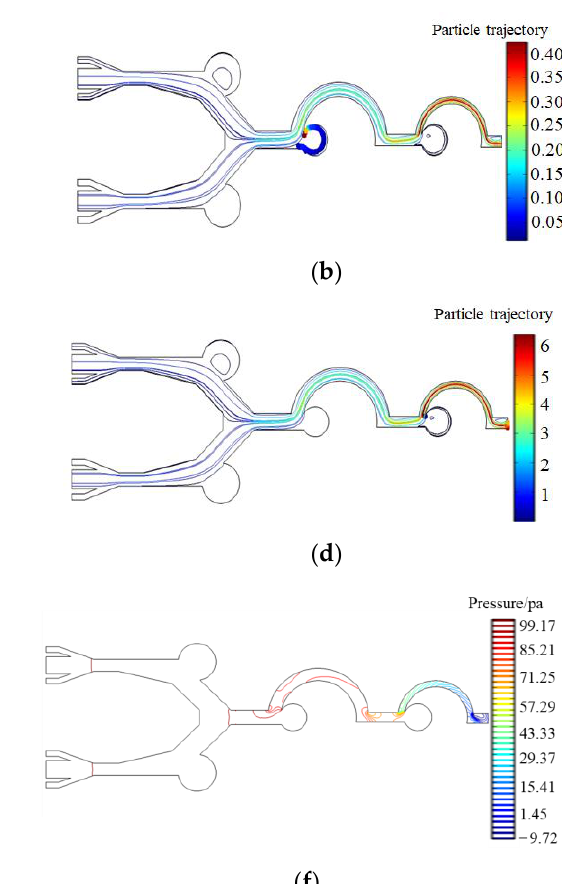
Figure 4. ( a ) Effect of W 3 /W 4 on the enrichment efficiency of 12 μm particles; ( b ) effect of W 5 /W 6 on the enrichment efficiency of 5 μm particles.